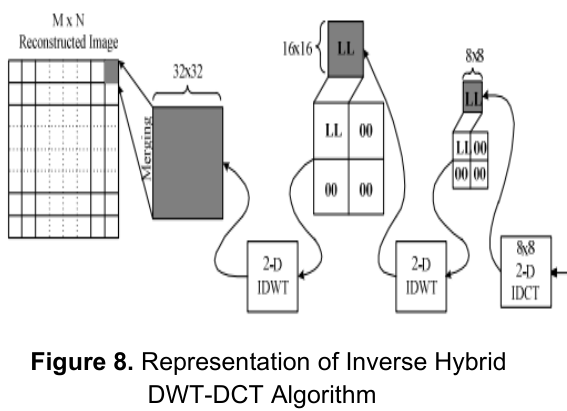
Figure 8. Representation of Inverse Hybrid DWT-DCT Algorithm Algorithm for Hybrid DWT-DCT: